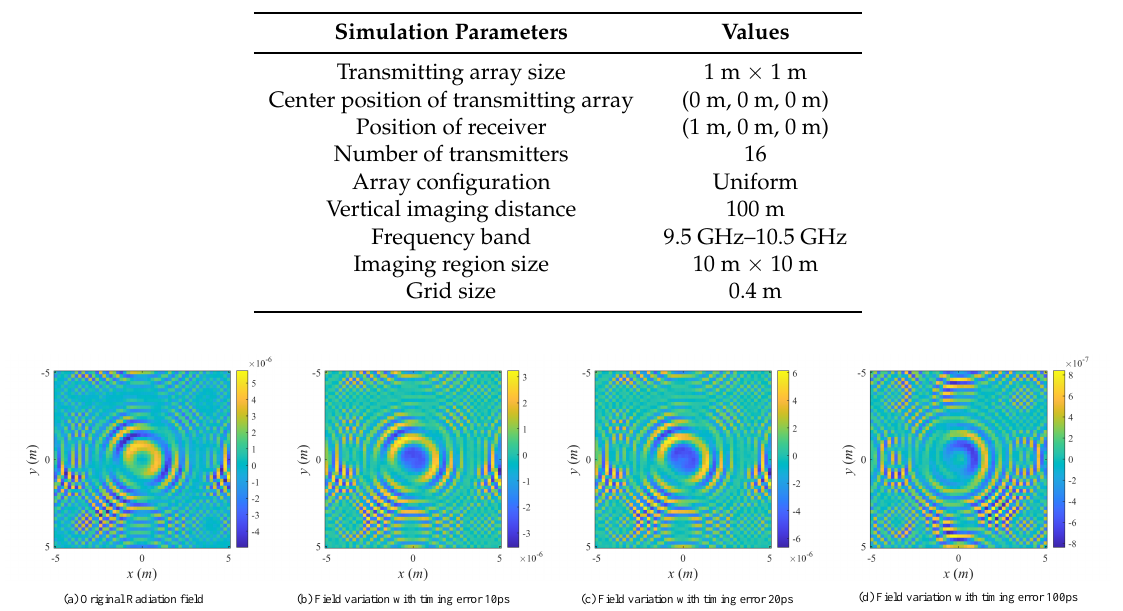
Table 1. Simulation parameters in MSCI based on random frequency-hopping (FH) waveforms.